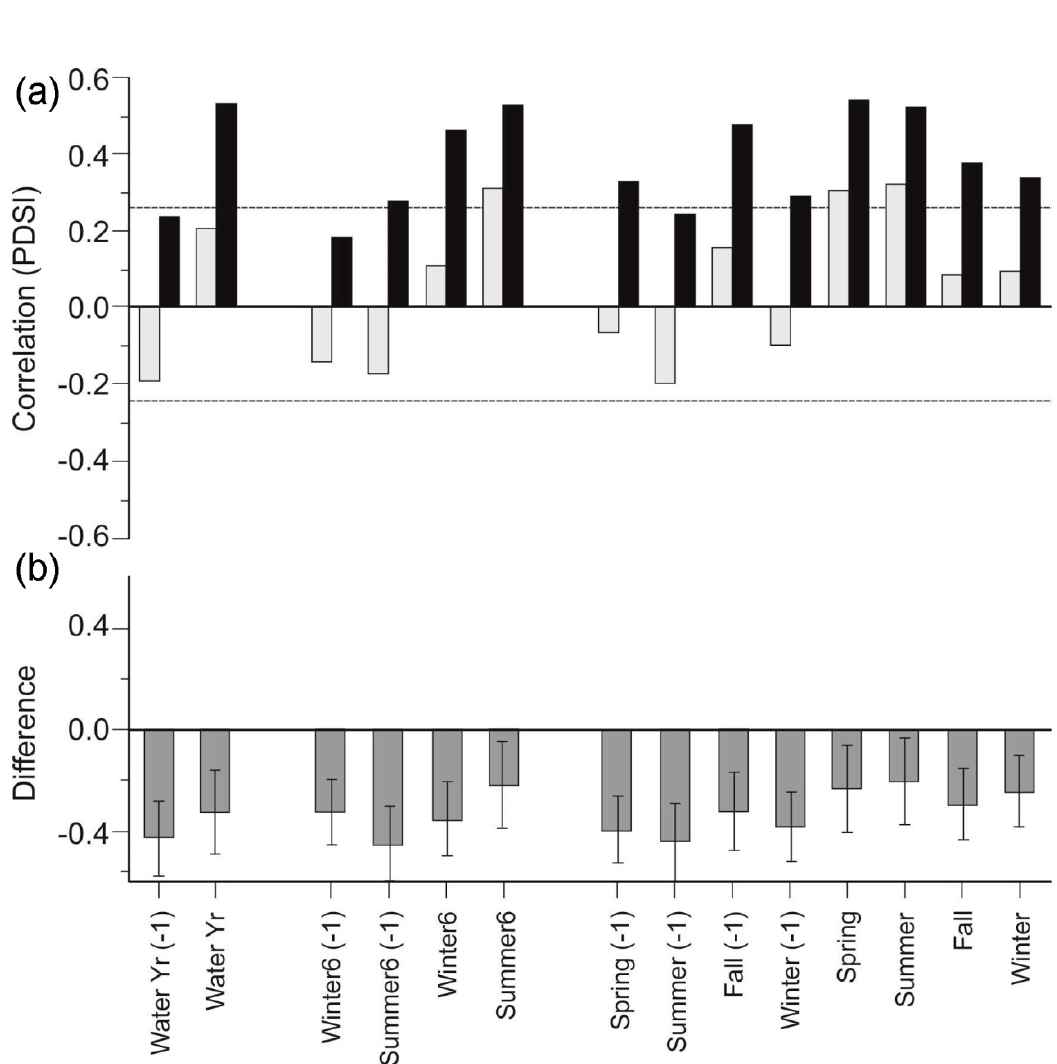
Figure 6. ( a ) Correlations between radial growth index of open-grown Oregon white oak (light gray) and closed-grown Oregon white oak (solid) and seasonal values of the PDSI (see text for time windows). Significance levels and confidence limits are indicated as in Figure 2. ( b ) Growth–climate response differences for the two chronologies. Positive values indicate that open-grown Oregon white oak are more positively correlated to the PDSI than closed-grown Oregon white oak during that season. The error bars indicate the 95% confidence limit on the difference.